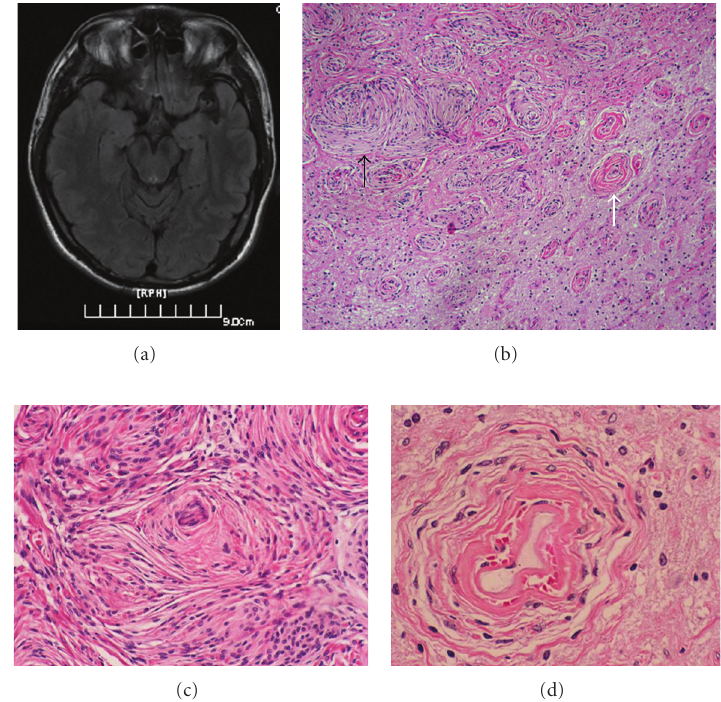
Figure 1: (a) MRI shows a low-signal intensity in the left temporal lobe on T1-weighted image; (b) transition area between MA (white arrow) and meningioma (black arrow), HE × 40; (c) transitional meningioma, HE × 200; (d) MA area is typical of collagenized vessels cu ff ed by meningothelial cells or fibroblasts under high power (HE ×